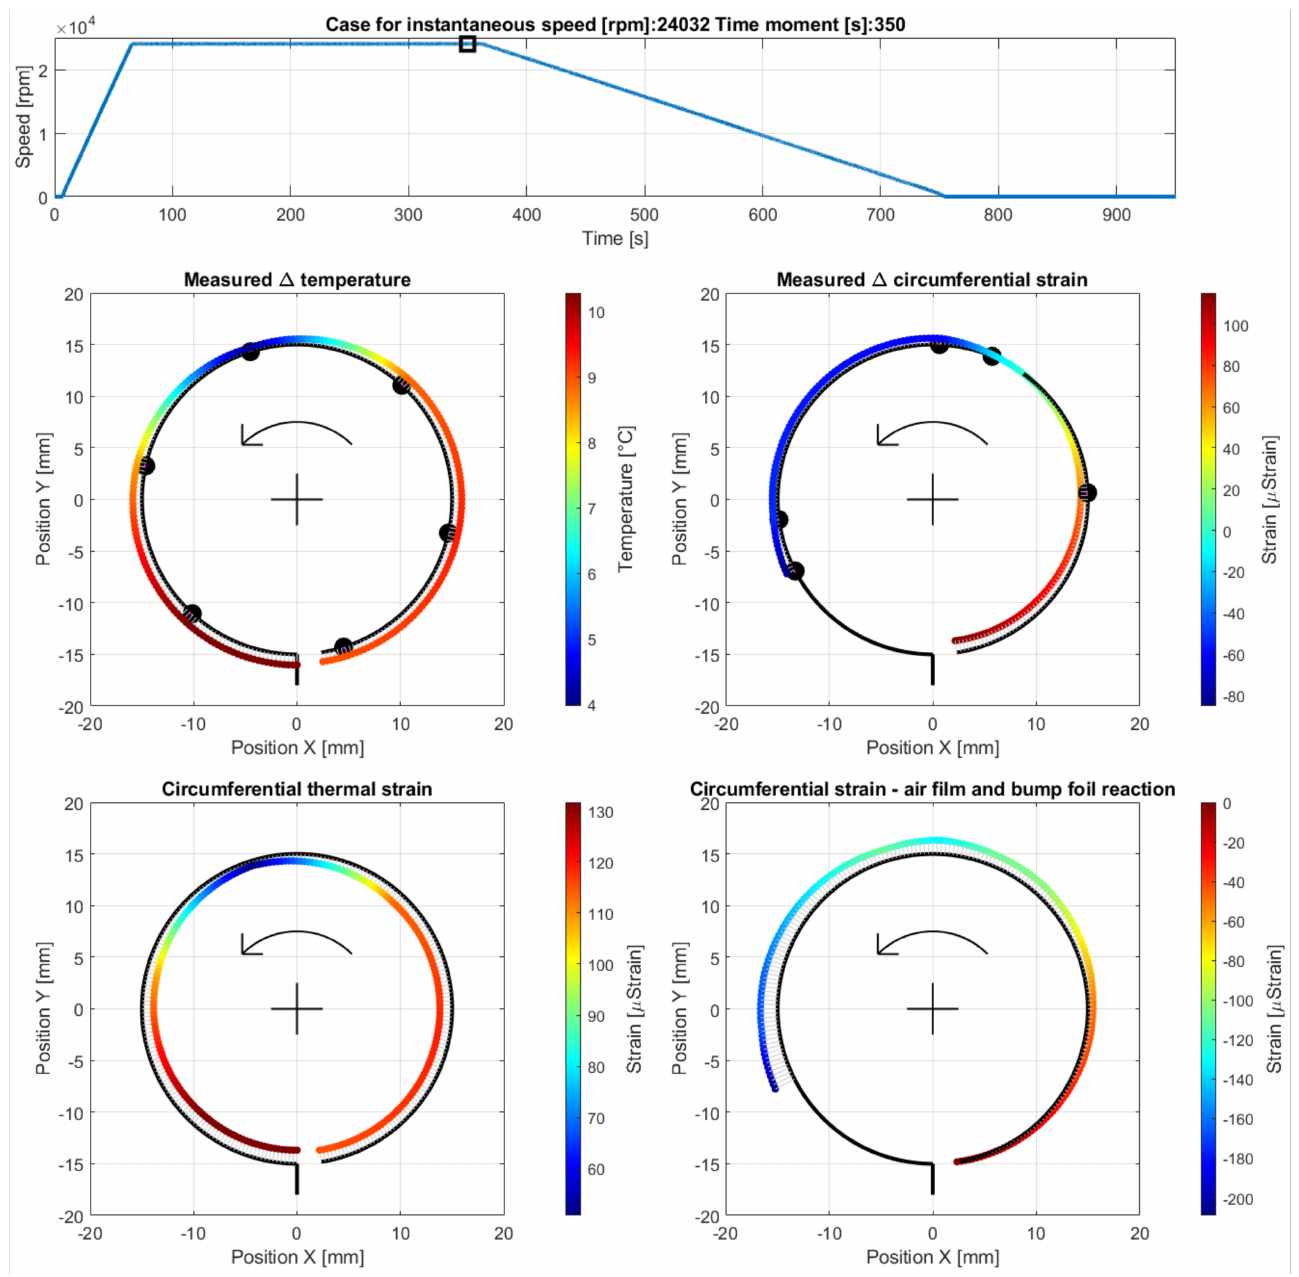
Figure 14. Cross-sectional views for the circumferential distribution of the temperature and strain identified in the top foil at 24,032 rpm during the stage of stable operation of the